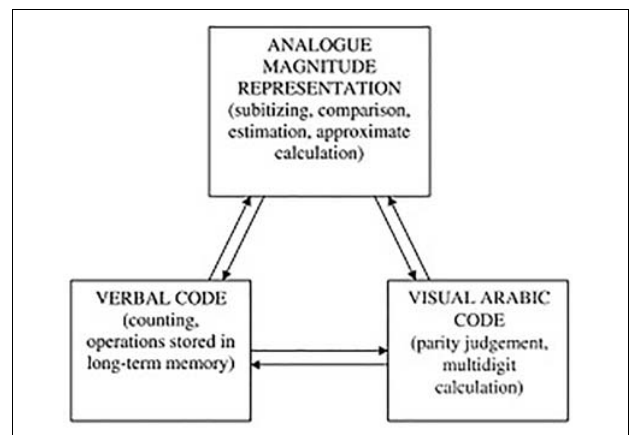
FIGURE 1 | Dehaene triple code model